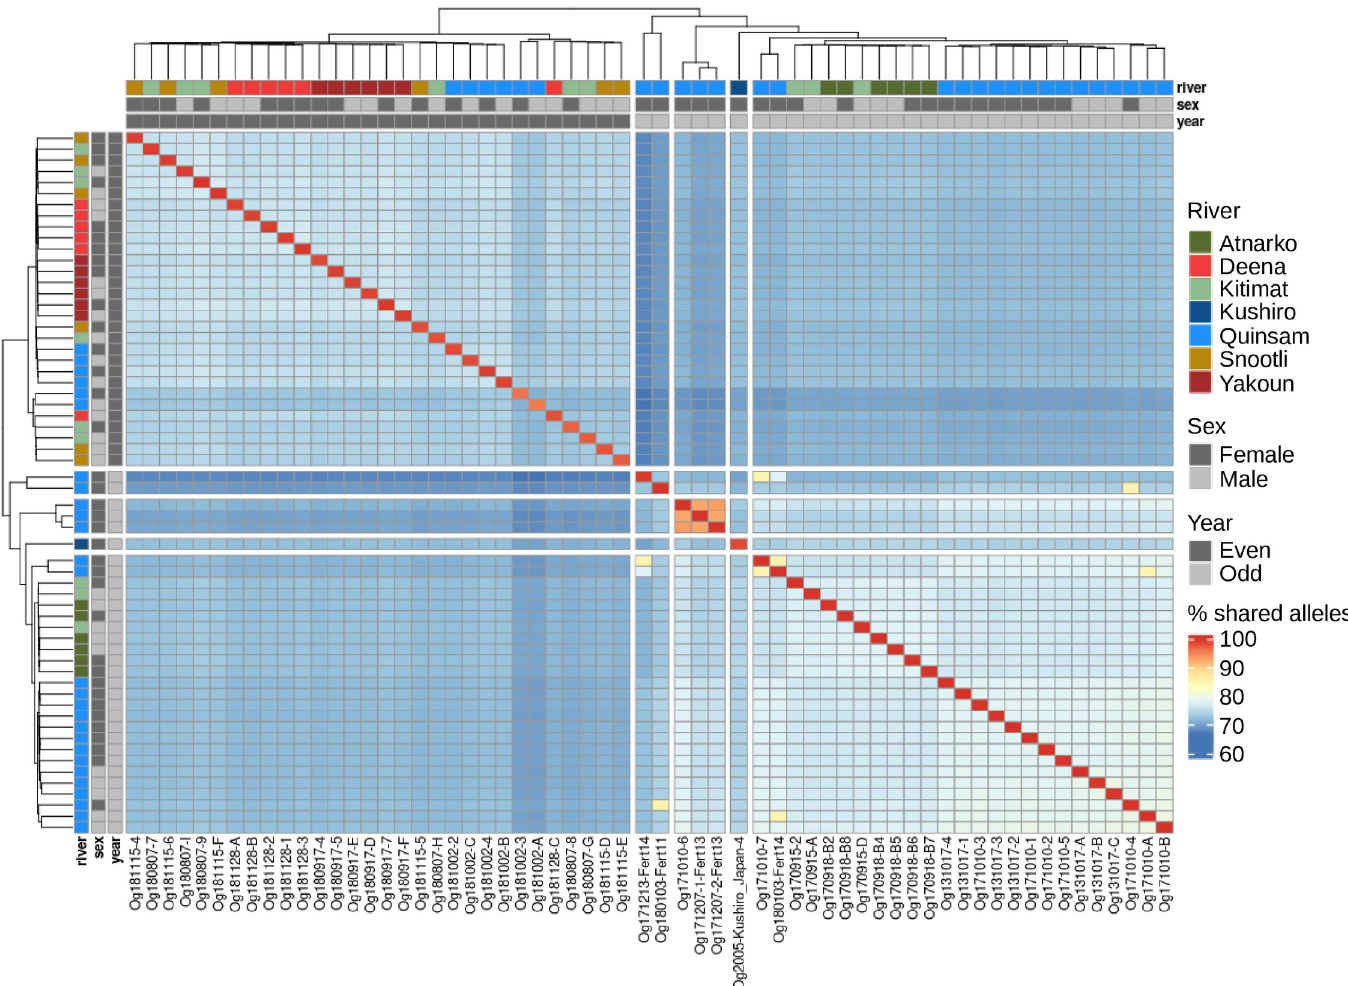
Fig 2. Percent of shared alleles among pink salmon. A heatmap of shared alleles between salmon is shown with clustering and a dendrogram. Each square represents the percent shared alleles after minor filtering of variants (bi-allelic SNPs). In addition to the legend displaying the colour representation of percent shared alleles, the sex, year-class, and river system sample information is colour-coded and shown on both rows and